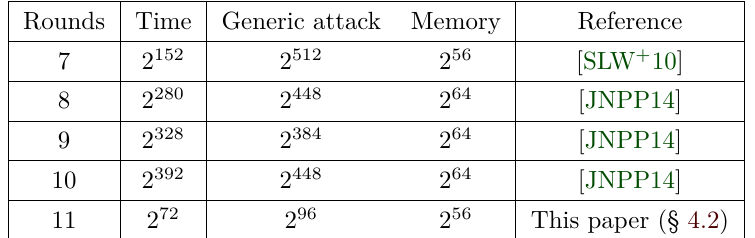
Table 1: Known rebound attacks on Grøstl-512 internal